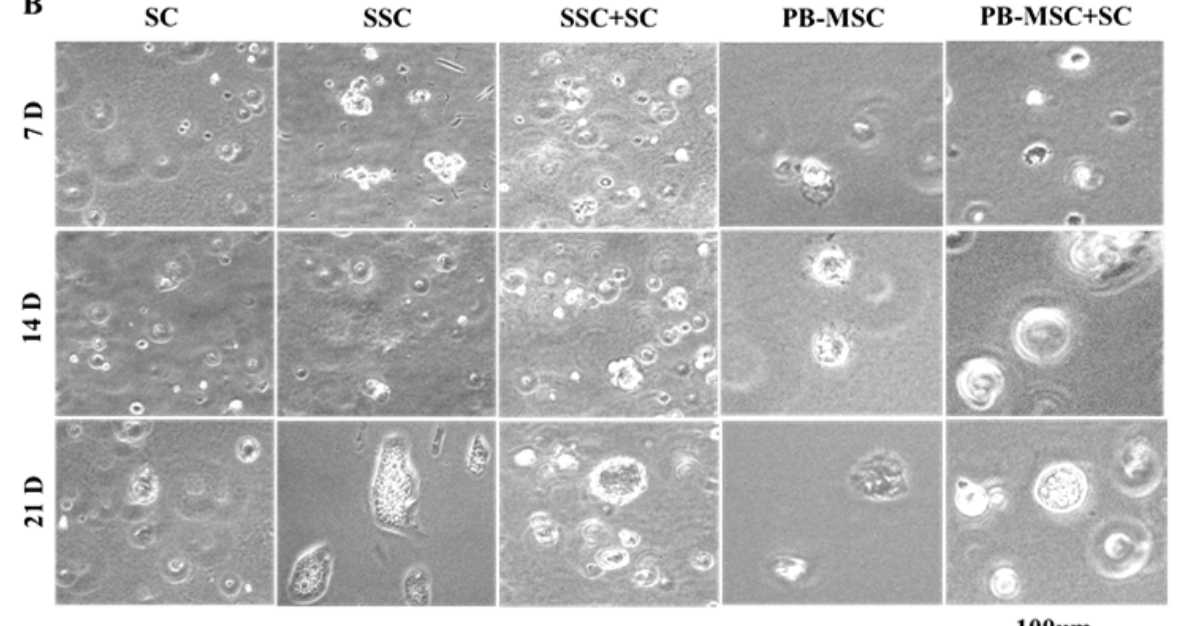
Figure 1. Phase contrast microscopy of single cultures and co-cultures in 3D SACS of bull PB-MSC, SC and SSC. ( A ) PB-MSC presented circular and fibroblastoid morphology at 5D of culture, elongated and heterogeneous morphology at 10D, and circular cells with large nuclei, triangular or circular shape at 15D. Bull SC formed a monolayer of large fibroblastoid cells with heterogenous morphology after removing GC from cultures at 3D of culture, and displayed triangular or circular subpopulations after 1–3 passages at 6D. Finally, distinct SC clusters were observed as cells became more confluent at 10D. Non-adherent SSC with a circular morphology were kept in suspension for 2D, and a population of SSC adherent with an irregular and cuboidal morphology appeared and formed colonies at 5D of culture. SSC proliferated quickly, and then they detached and floated at 7D. ( B ) In 3D SACS, SSC formed large colonies on day 21, PB-MSC and SC lost the elongated fibroblastoid appearance to a circular or cuboidal shape. During culture in 3D SACS, round colonies that increased in size and number could be observed in the SSC+SC and PB-MSC+SC